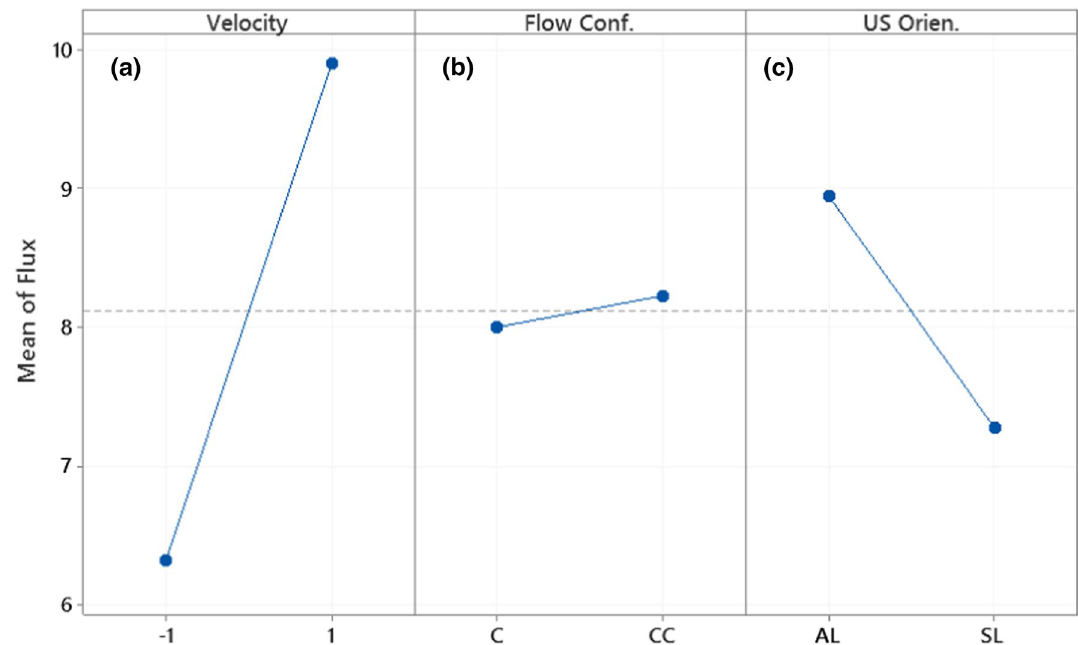
Fig. 5 Plots of the main effects of a CFV, b flow configuration, and c ultrasound orientation on the water flux (L/m 2 ·h) for MgCl